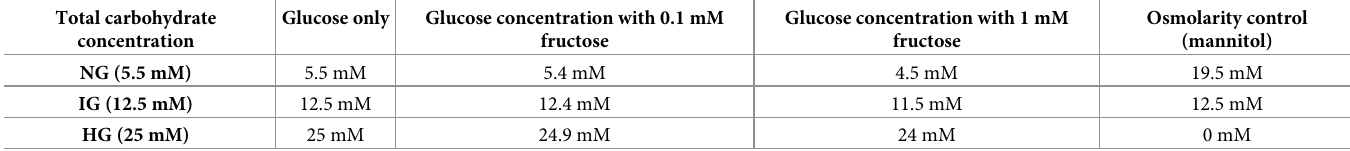
Table 1. Composition of test glucose and glucose/fructose medium for the intermittent